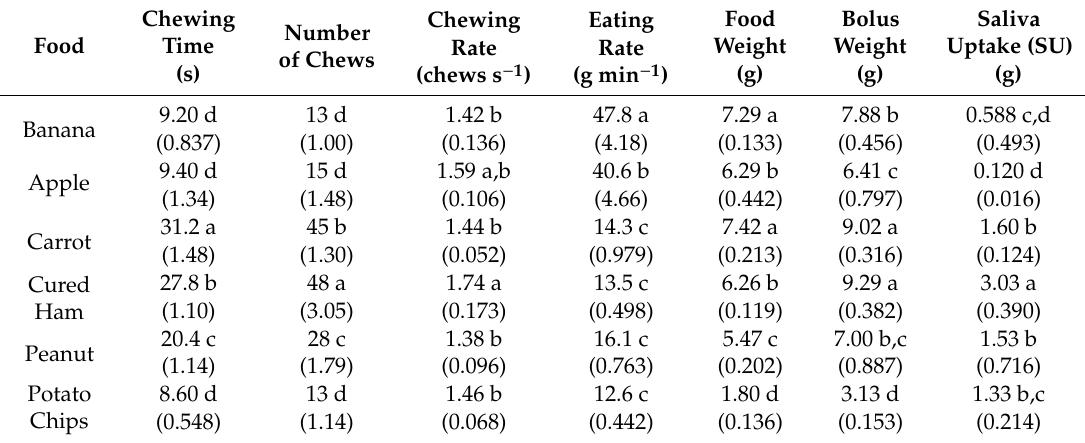
Table 4. Oral processing behavior and bolus saliva uptake of a healthy young male volunteer for the selected